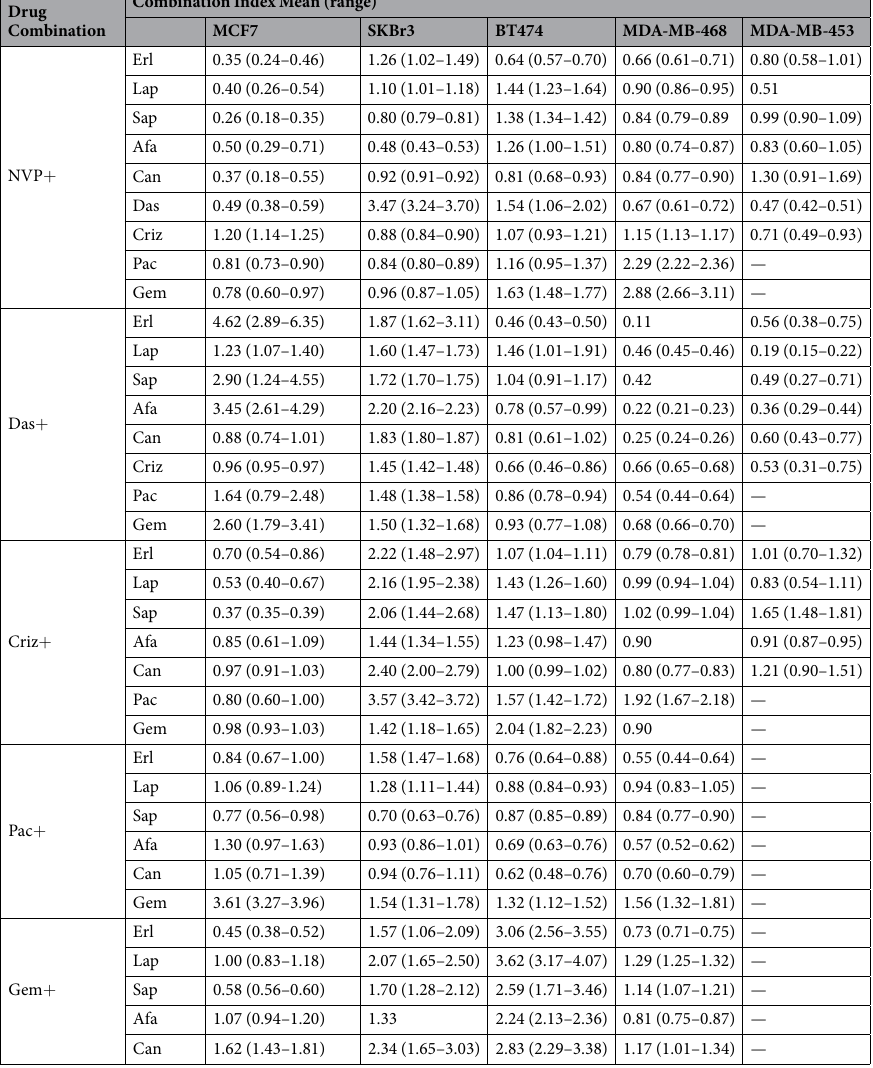
Table 3. Combination Indices for combined agents on cell lines MCF7, SKBr3, BT474, MDA-MB-468 and MDA-MB-453. Each value is the mean of triplicate samples from two independent experiments. Combination Index values < 0.9 = synergy; > 1.1 = antagonism; 0.9–1.1 = additive. NVP = NVP-AEW541; Das = Dasatinib; Criz = Crizotinib; Pac = Paclitaxel; Gem = Gemcitabine; Erl = Erlotinib; Lap = Lapatinib; Sap = Sapitinib; Afa = Afatinib; Can = Canertinib; Das = Dasatinib; Criz = Crizotinib; Pac = Paclitaxel; Gem =